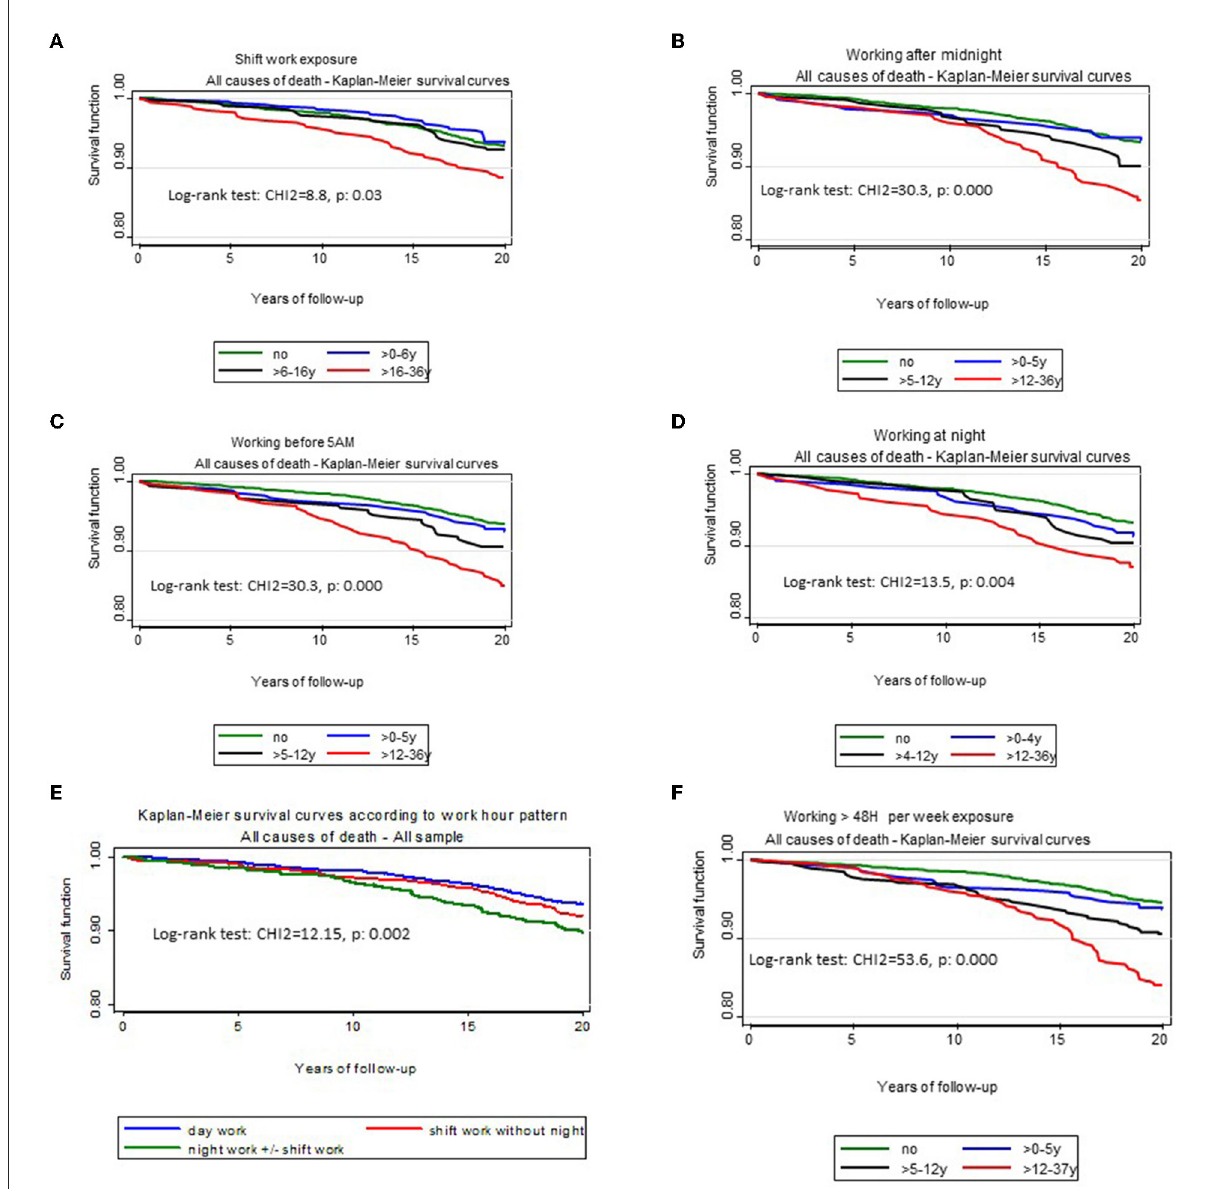
FIGURE2 Kaplan-Meier survival curves for all-cause mortality according to exposure duration of occupational organizational constraints. (A) Kaplan–Meier survival curves according to exposure duration to shift work. (B) Kaplan–Meier survival curves according to exposure duration of working after midnight. (C) Kaplan–Meier survival curves according to exposure duration of working before 5:00a.m. (D) Kaplan–Meier survival curves according to exposure duration of working at night. (E) Kaplan–Meier survival curves according to working hour schedule. (F) Kaplan–Meier survival curves according to exposure duration of working > 48 h/week.